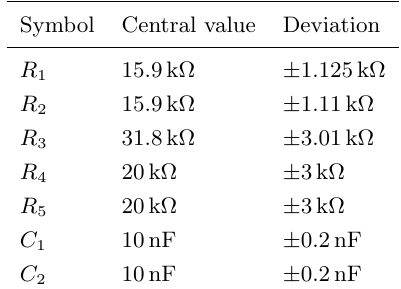
Table 2: Parameters for bandpass circuit in Fig.